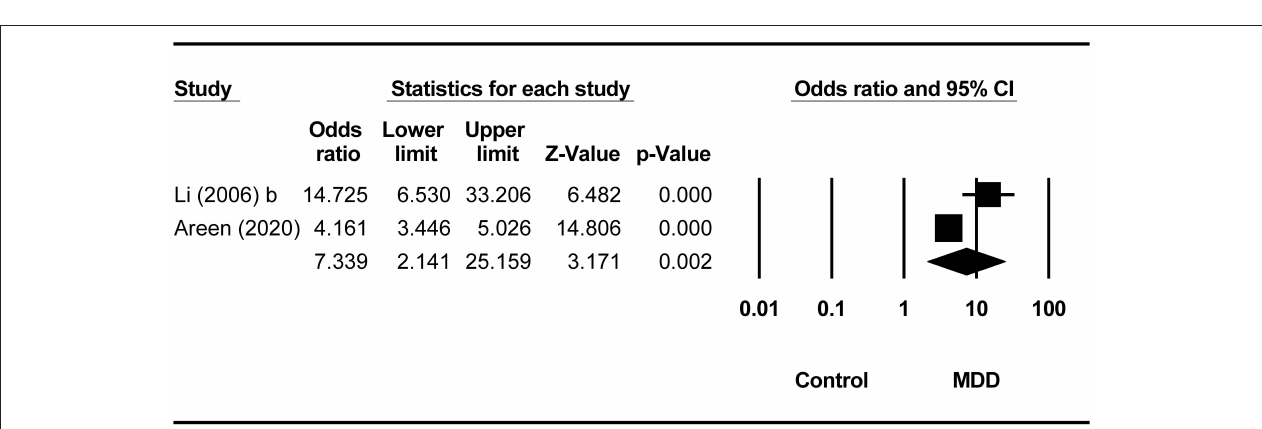
FIGURE 3 | Comparison of lifetime prevalence of suicide attempts between MDD and non-MDD groups.